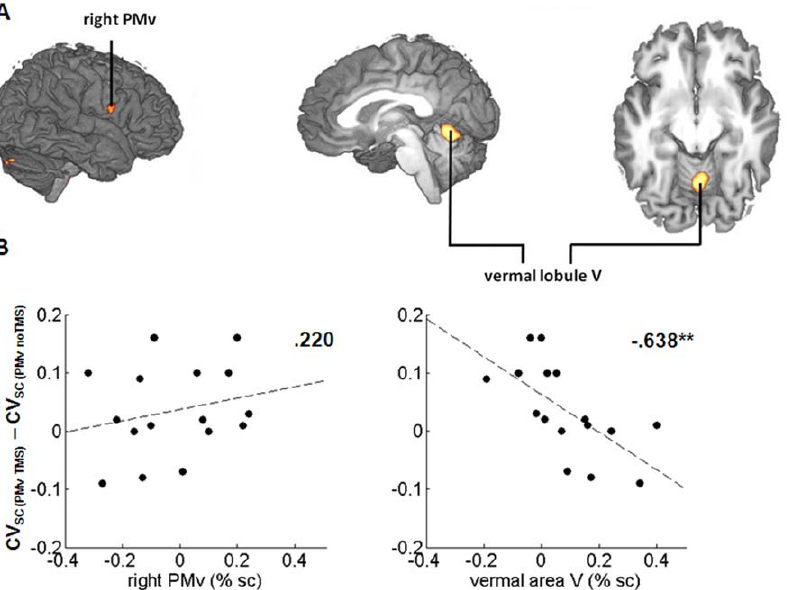
Figure 5. Compensatory activity following left PMv rTMS. A: rTMS over the left PMv triggered state-dependent activity increases (SC vs. CC, conjunction of rTMS PMv vs. no rTMS PMv, rTMS PMv vs. rTMS AG and rTMS PMv vs. no rTMS AG) in the right PMv (a priori hypothesis; uncorrected, displayed at p , .01) and the anterior midline cerebellum (corrected at p , .01). B: In contrast to right PMv activity (left side), the task-dependent cerebellar activity (right side) during the first five-minute sub-block following rTMS over the PMv predicted the preservation of auditory-motor synchronization accuracy (CV SC ). Subjects with higher activity increase in the vermal lobule V following rTMS over the PMv were more likely to retain synchronization